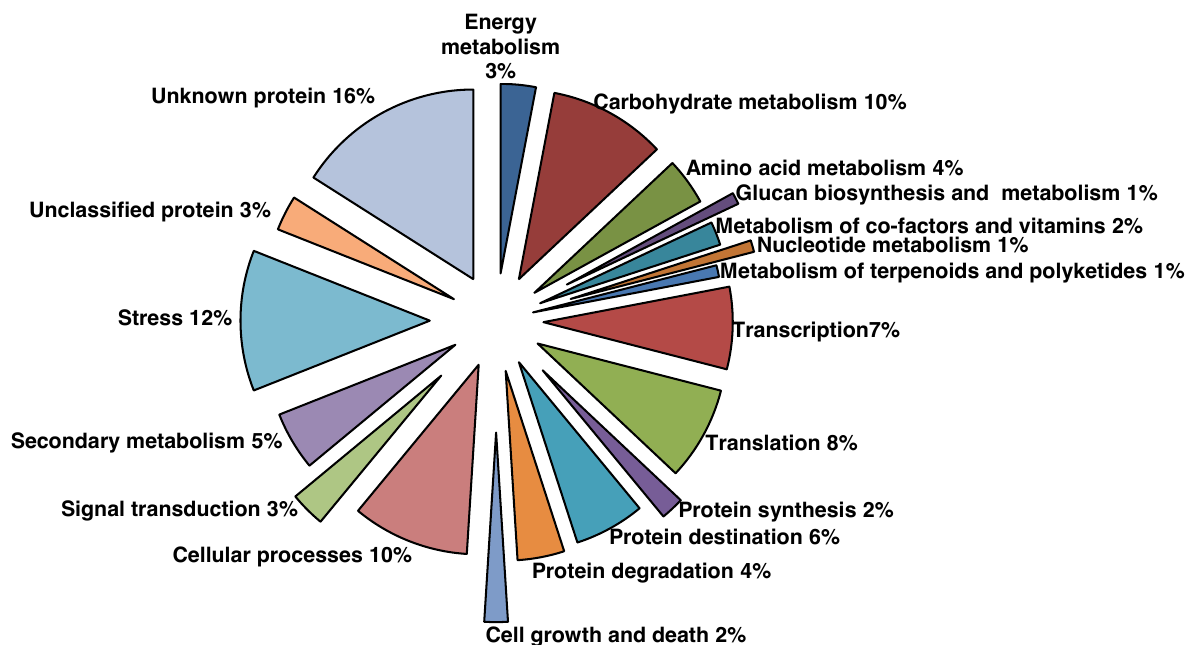
Figure 1. Functional classification of identified proteins from the trunks of fieldgrown Vitis vinifera plants affected or not by the grapevine trunk disease. The proteins were classified into 19 functional groups by using GenomeNet Database Re - sources website (http:www.genome.jp/kegg) and reports in the